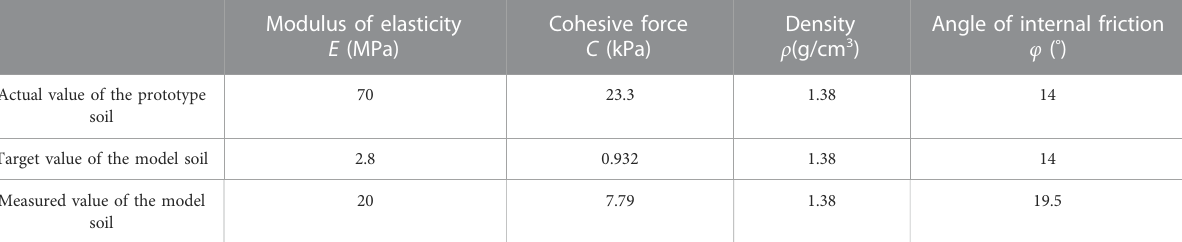
were selected for the test because only horizontal and vertical two-directional seismic loadings were tested. The arrangement of the acceleration sensors used in the test is shown in Figure 4.